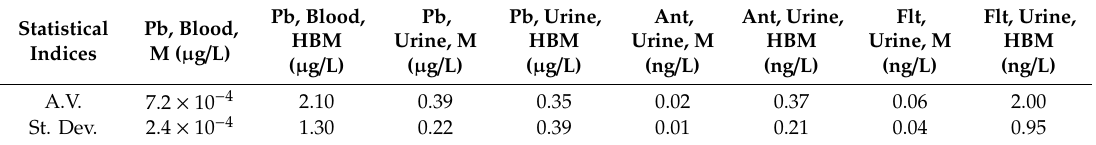
Table 8. Comparison between contaminant concentrations estimated by MERLIN software (M) and measured concentrations reported in the Human Bio-monitoring study (HBM) in the NE group: average value (A.V.) and standard deviations (St. Dev.). Pb = Lead, Ant = Anthracene, Flt = Fluoranthene.